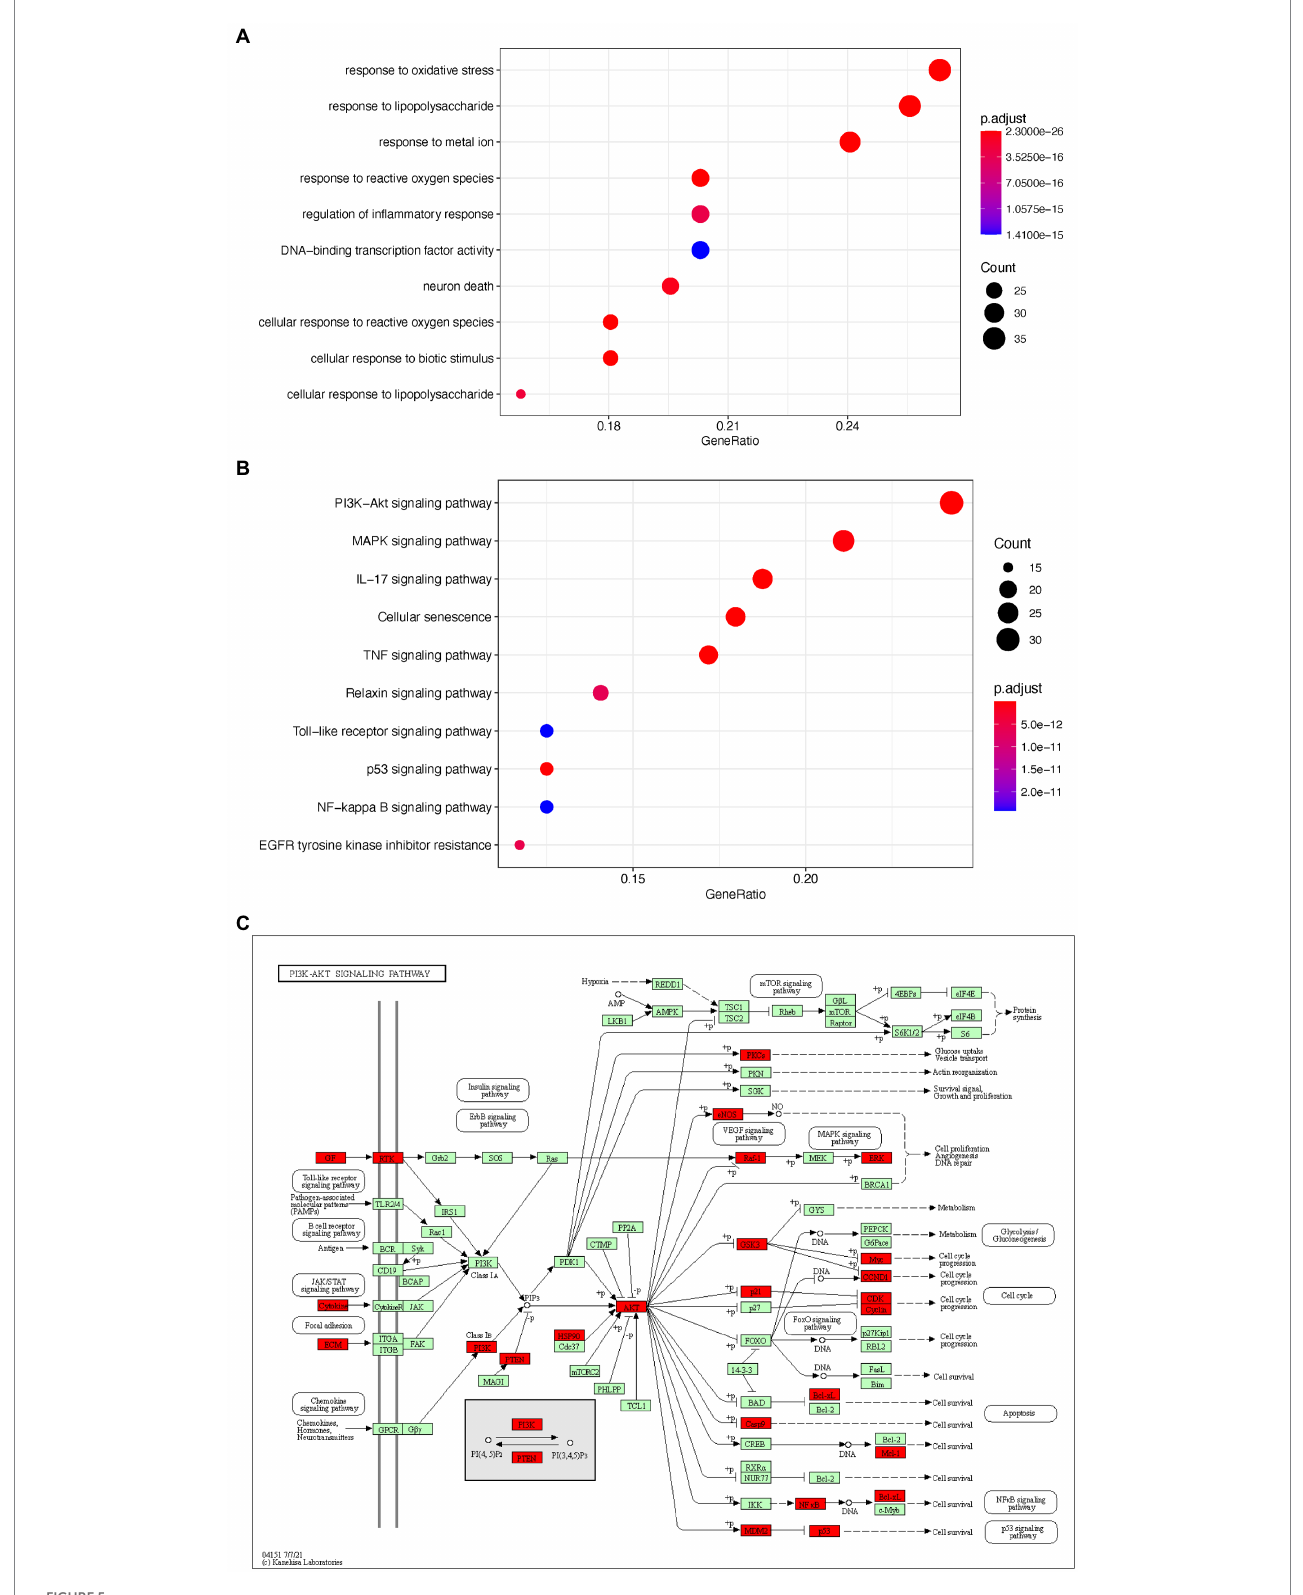
FIGURE 5 The GO and KEGG enrichment analysis of the potential targets of EPI for SCI. (A) the top 10 enriched GO terms. (B) The top 10 enriched KEGG signaling pathways. (C) PI3K/AKT signaling pathway map (Green and red are all genes on the PI3K signaling pathway, and red represents the targets of EPI for SCI). PI3K/AKT signaling pathway map is mined here from